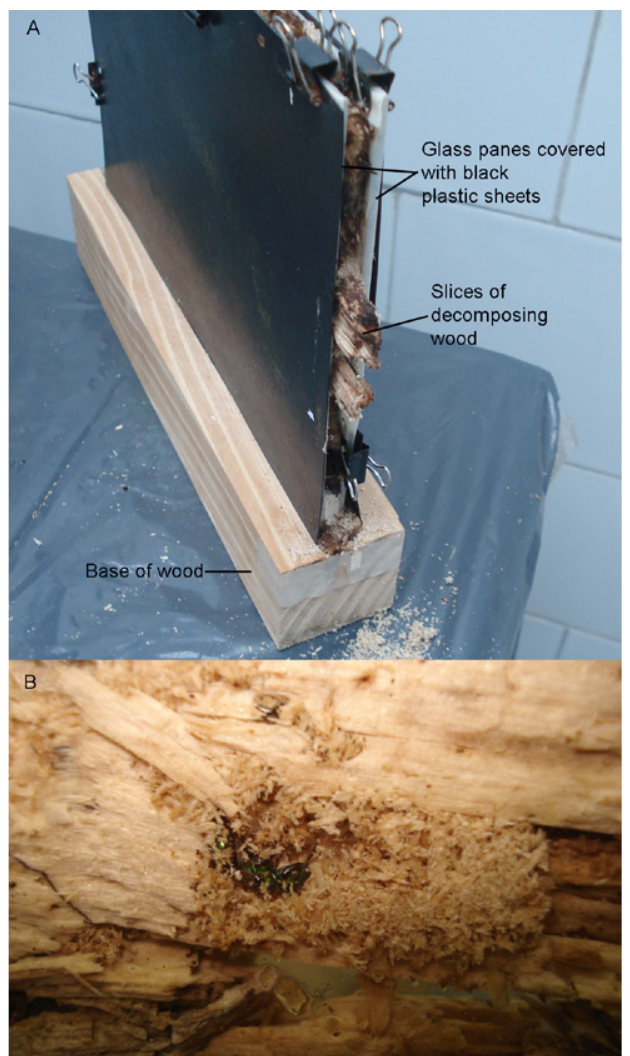
Fig 1 . A- Artificial nest where the colonies of Augochlora amphitrite were reared; B- daughter female and sawdust from cell construction between the glass panes of the artificial